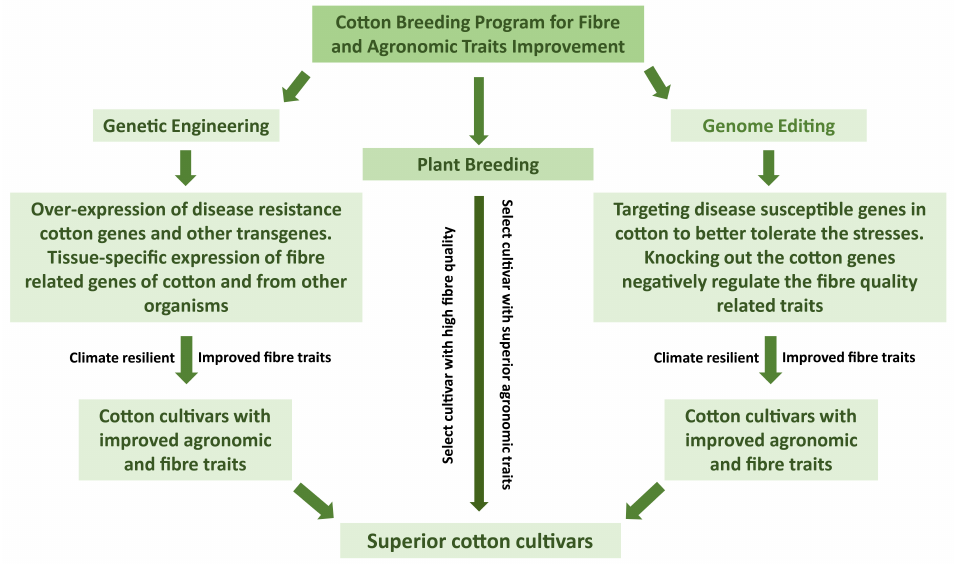
Figure 2. Proposed revamped cotton breeding program. Fine-tune the already present traits and add new traits to cultivated cotton varieties through plant breeding, genetic engineering, and genome editing tools. Pyramiding of useful traits by crossing between genetically altered and elite cultivars to develop climate resilient cotton cultivars.